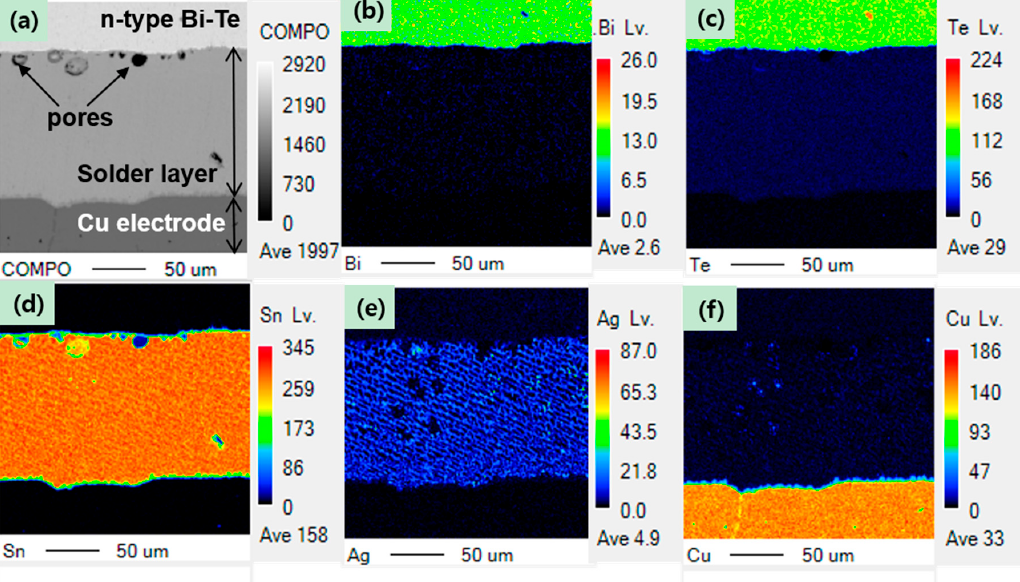
Figure 4. Component analysis and cross-sectional observations of the bonding interface between solder and n-type thermoelectric element without electroless Ni–P plating using field emission electron probe microanalysis (FE-EPMA). ( a ) BSE image; ( b ) Bi element map; ( c ) Te element map; ( d ) Sn element map; ( e ) Ag element map; and ( f ) Cu element map.